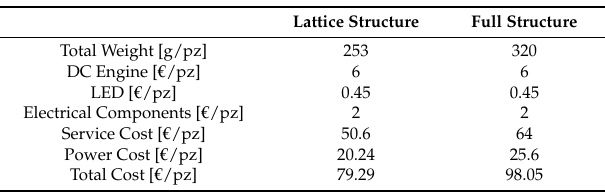
Figure 21. Final result achieved.